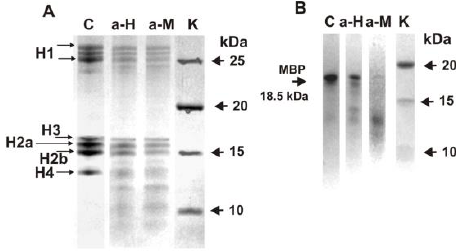
Figure 1. SDS-PAGE analysis hydrolysis of five histones (H1 – H4) by IgGs-abzymes against these five histones (lane a-H) as well as MBP (lane a-M) ( A ) and human myelin basic protein by IgGs against five histones (lane a-H) and Abs-abzymes against MBP (lane a-M) ( B ). MBP and a mixture of five histones with and without IgGs (0.03 mg/mL) were incubated for 12 h. Lane C corresponds to the histones ( A ) and MBP ( B ) incubated without IgGs. Lane K — proteins with known molecular masses ( A , B ).